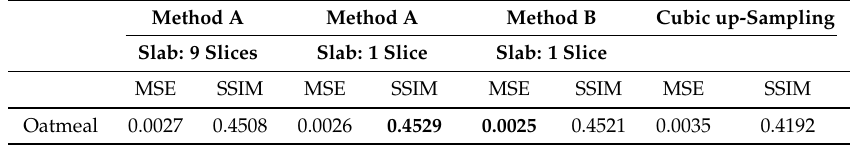
Figure 9. Oatmeal data: results of applying the trained networks to the central slice of the upper region of interest. The low-resolution slice (shown left) was not part of the training set. The high-resolution slice is the result of reconstruction (Equation (12)). The four images on the right are computed from the input using our proposed methods and cubic up-sampling. Magnifications of the central yellow square are displayed in the second row. The red ellipse highlights a flake that is partially visible in the input, and is correctly removed by all three methods. The output of method B is cubically up-sampled by a factor of 4 to be the same size as the other images. Table 5. Oatmeal: comparison of the MSE and SSIM between the output of the three approaches described in this section and cubic up-sampling. The best results are shown in bold for each